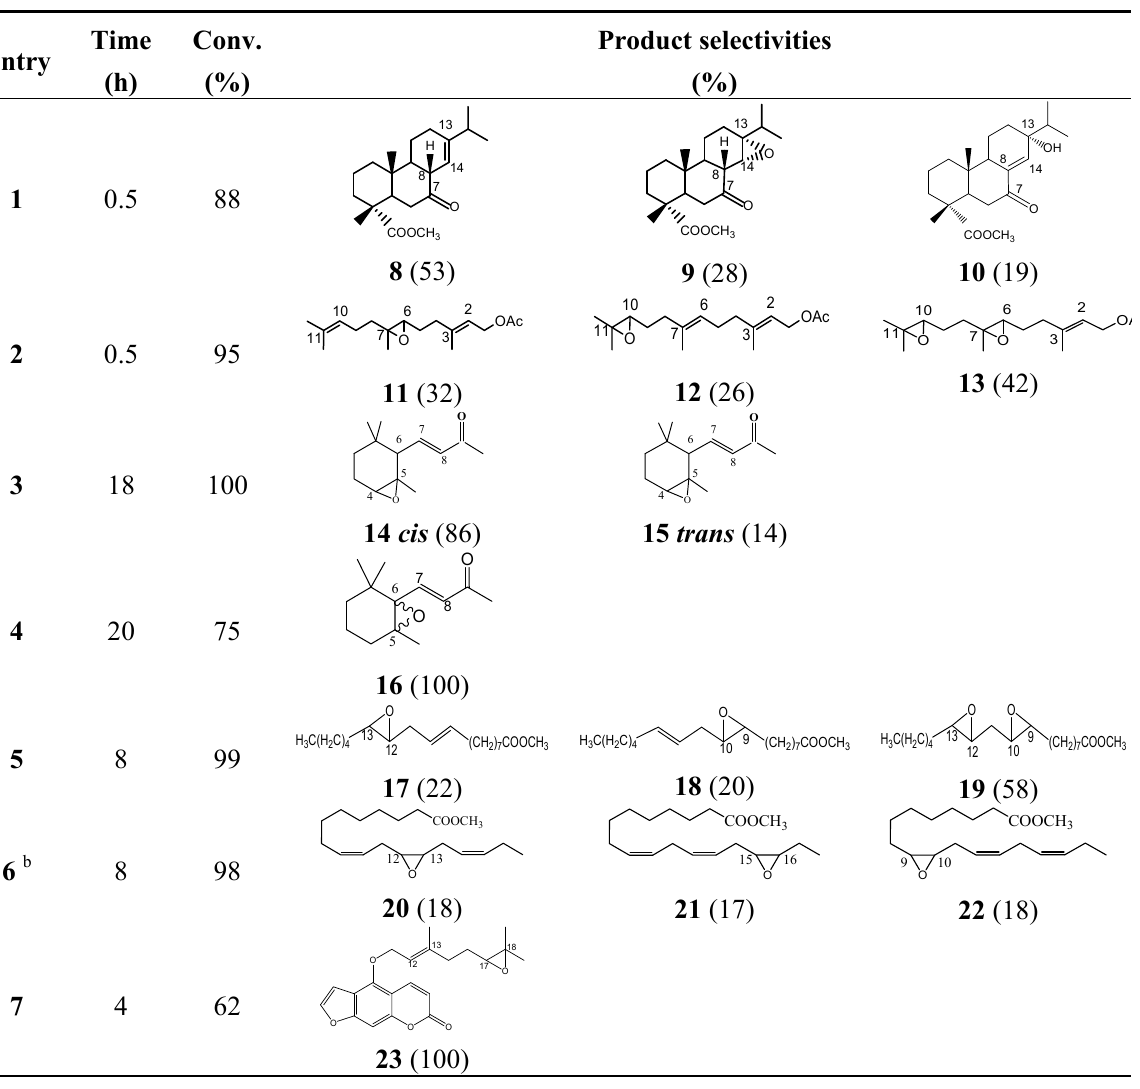
Table 1. Oxidation products of selected natural compounds with MTO/H Cl at 25 °C a CH 2 2